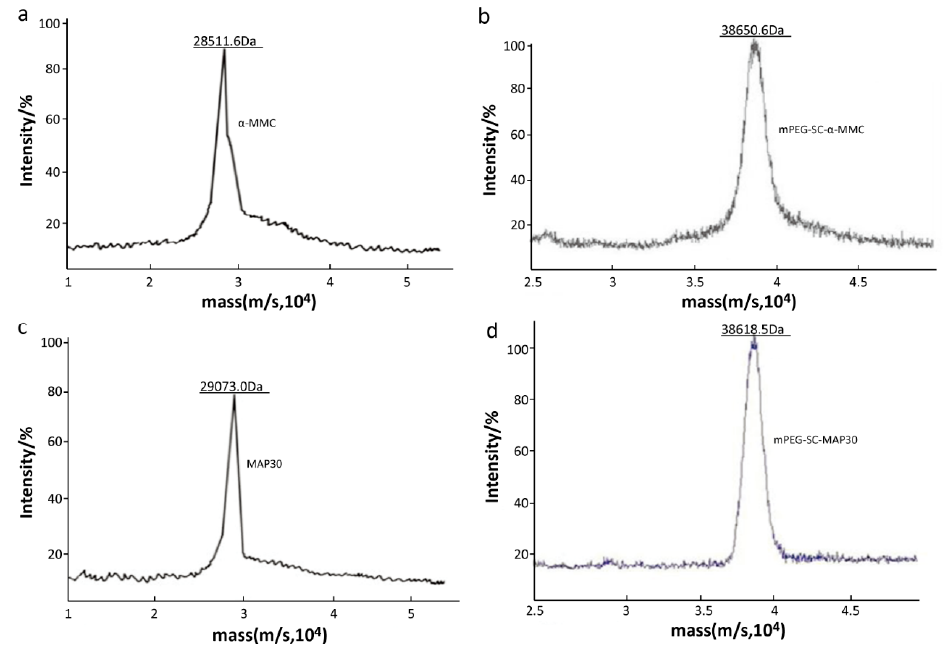
Figure 3. MALDI-TOF/TOF analysis of RIPs and 10 kDa mPEG-SC-RIPs. ( a , c ): MALDI-TOF/TOF profile of α -MMC and MAP30. The average molecular weights were 28,551.6 Da and 29,073.0 Da; ( b , d ): MALDI-TOF/TOF profile of 10 kDa mPEG-SC- α -MMC/MAP30. The average molecular weights were 38,650.6 Da and 38,618.5 Da.